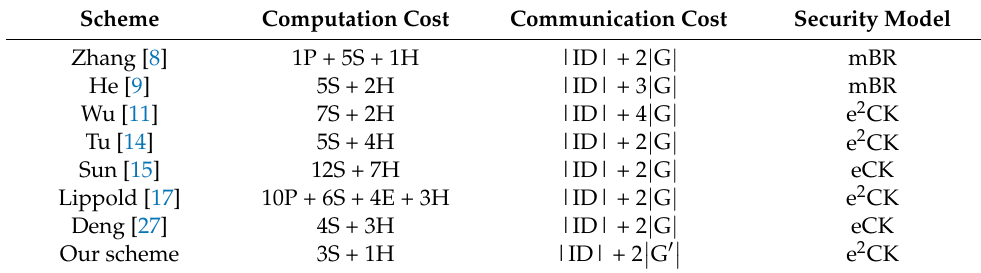
Table 1. Comparison of the schemes.